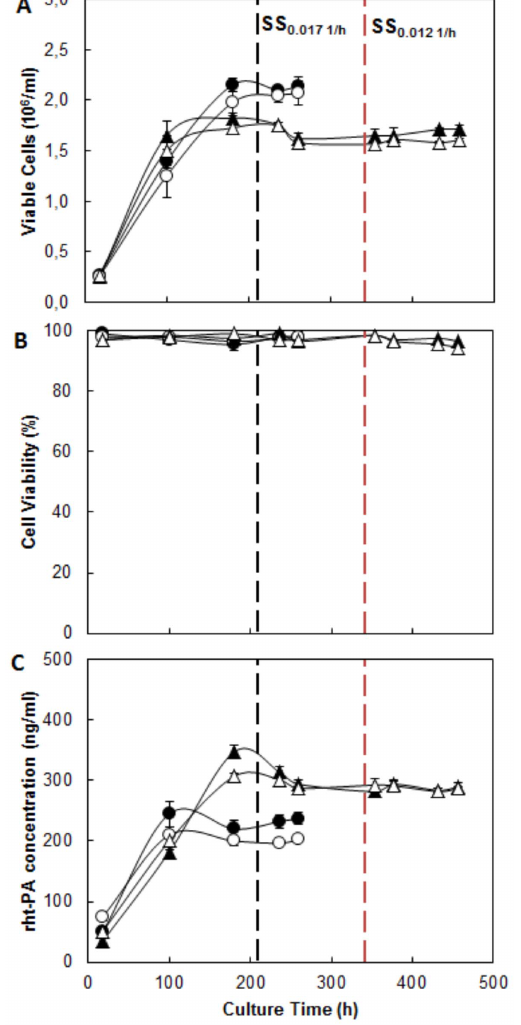
Figure 1. Profile of CHO cells growing, viability and rht-PA production at different culture temperatures and dilution N rates. A: Viable cell concentration. B: Viability percentage. C: rht-PA Condition 37 u C and 0.017 h 2 1 ; # Condition 33 u C and concentration. 0.017 h 2 1 ; m Condition 37 u C and 0.012 h 2 1 ; n Condition 33 u C and 0.012 h 2 1 . Black dotted line: Start of SS 0.017 h 2 1 . Red dotted line: Start of SS 0.012 h 2 1 .